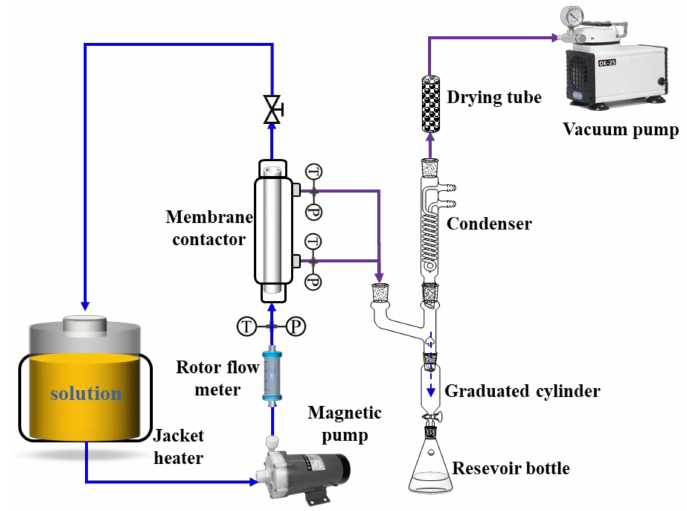
Figure 8. Schematic diagram of the membrane distillation